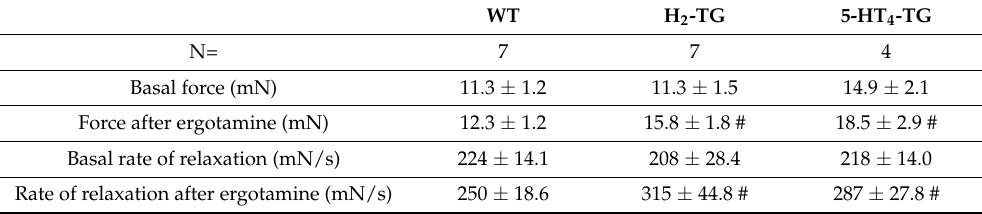
Table 1. Maximum effect of ergotamine (10 µ M) on force of contraction in milli-Newton (mN) and the rate-of-tension relaxation mN/seconds (mN/s) in isolated perfused hearts from H 2 -TG, 5-HT 4 -TG and WT. # indicate p < 0.05 versus pre-drug (ergotamine) value. N = number of animals. WT H 2